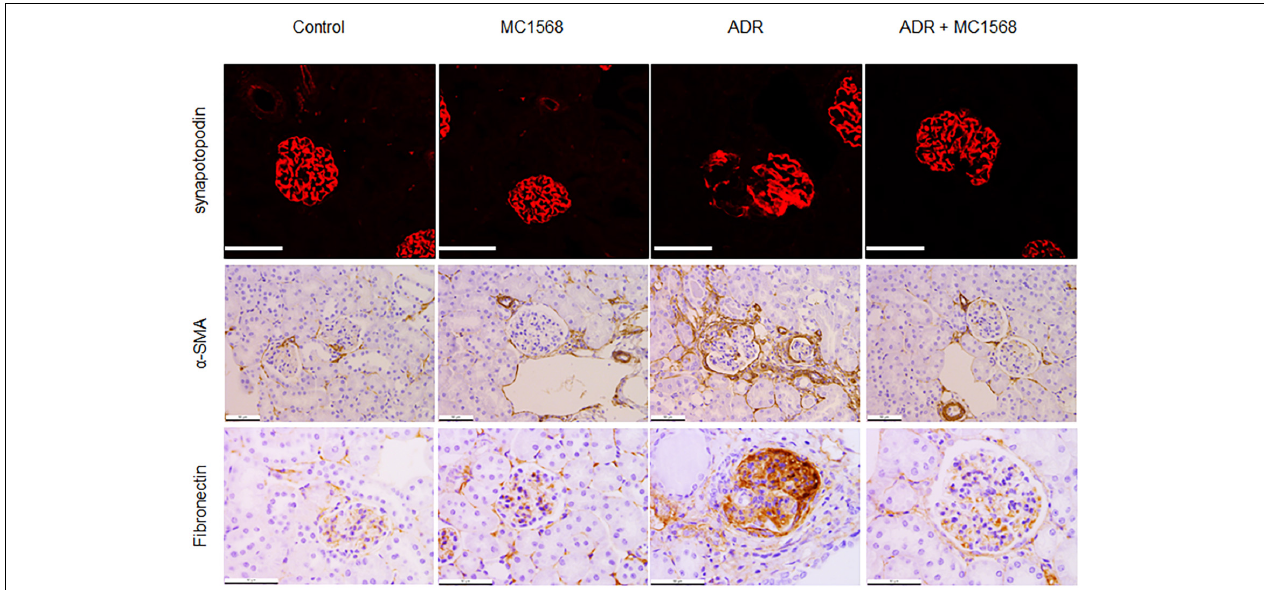
FIGURE 7 | Inhibitory effects on podocyte markers. Representative images of immunohistochemical (IHC) and immunofluorescence (IF) staining of Synaptopodin, α -SMA, and Fibronectin in control and ADR-injected mice treated with or without MC1568. Scale bar, 50 µ m.